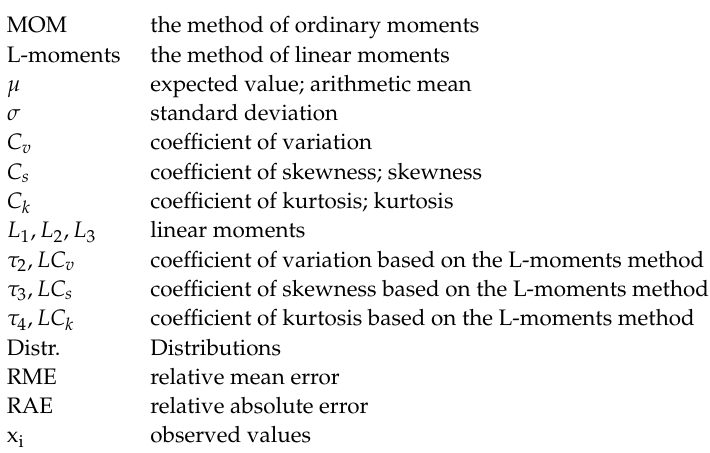
Figure A1. The variation diagram of LC s